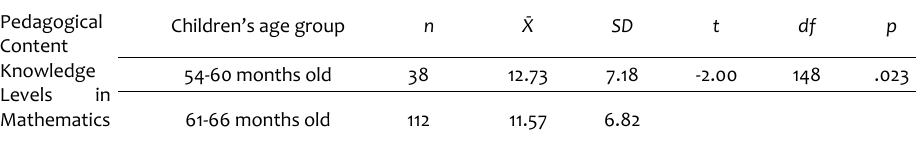
Table 5. Distribution of teachers’ pedagogical content knowledge levels in mathematics by children’s age group Pedagogical Content Knowledge Levels